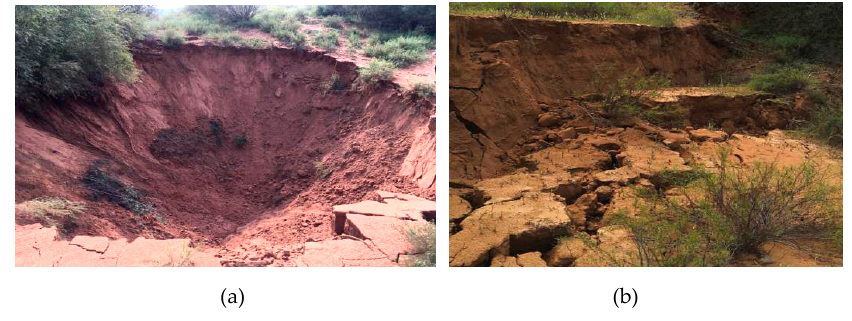
Figure 20. Field surface cracks: (a) sinking funnel; (b) step crack.